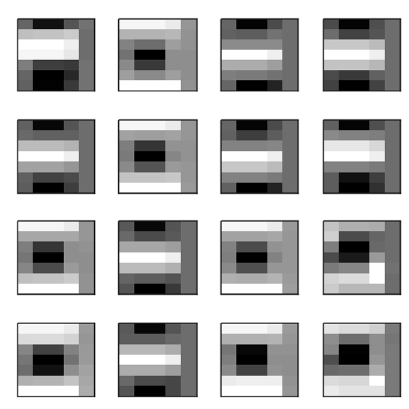
Figure 10. Final features after average pooling.